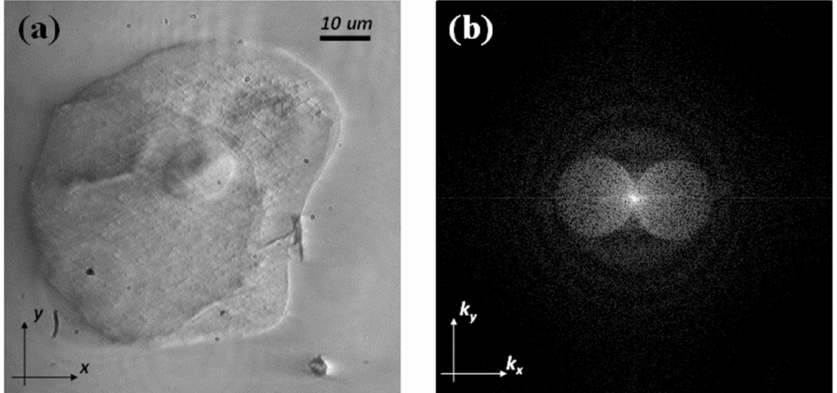
Figure 4. Intensity raw image from the experimental setup ( a ) 2D intensity image for human cheek cell. ( b ) 2D Fourier transform of the image shown in ( a